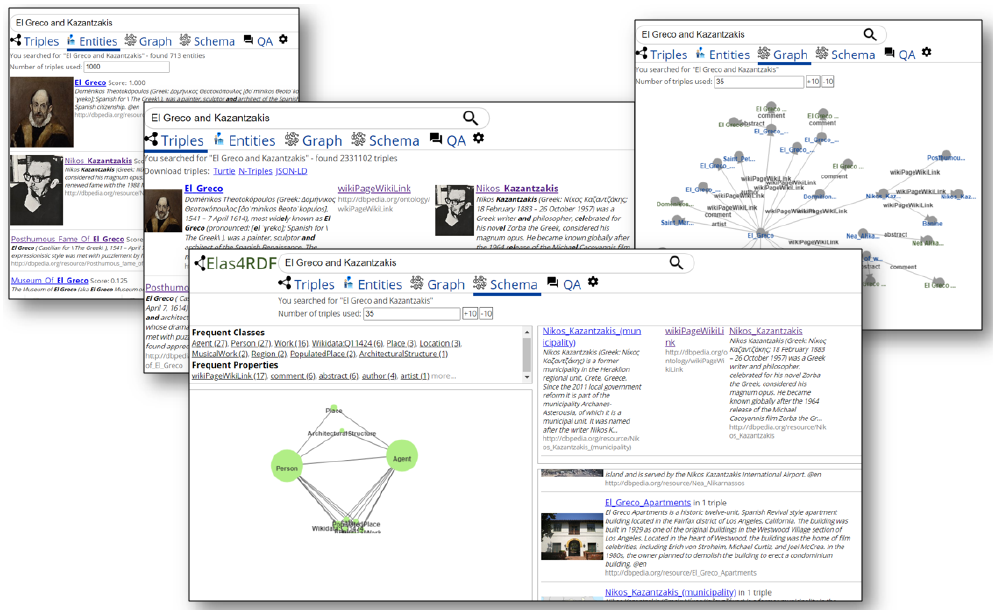
Figure 5. Search results for the query “ El Greco and Kazantzakis